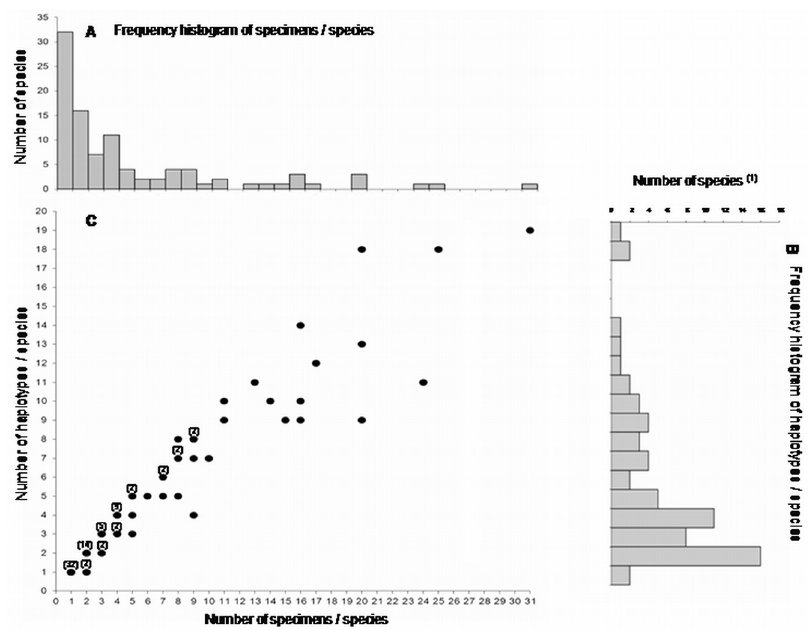
Fig 3. Frequency histograms of specimen numbers (A), number of haplotypes per species (B) and changes in the number of haplotypes with respect to the number of specimens sampled per species (C). In the latter, for each dot that represents more than one species, the number of species is given. ‘ Species ’ refers to the number of nominal species. (1): species represented by only one specimen are